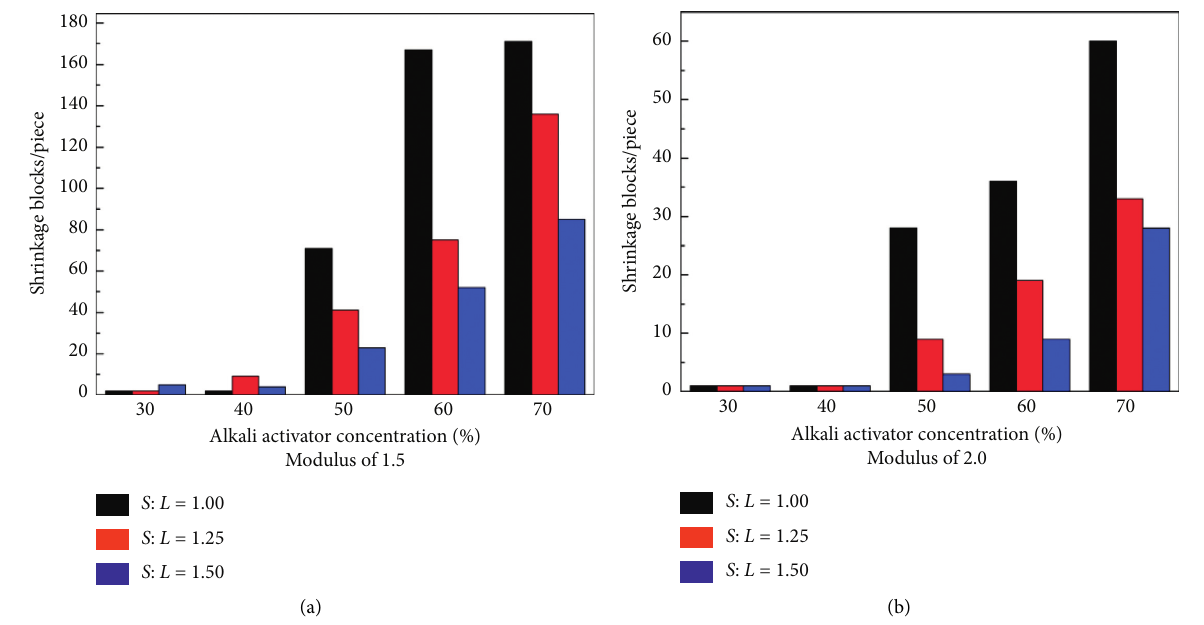
Figure 7: Influence of the sodium silicate modulus on the number of shrinking geopolymer blocks.